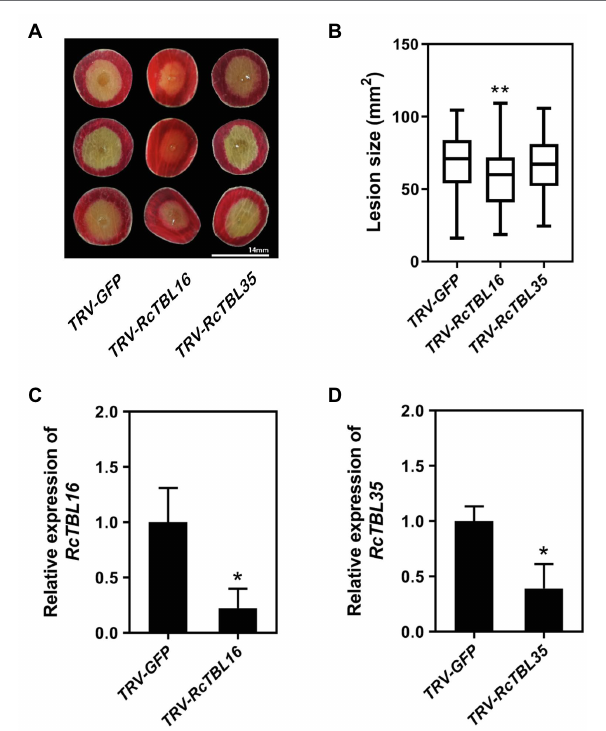
TABLE 4 | Expression patterns of RcTBL genes under infection of B. cinerea 1